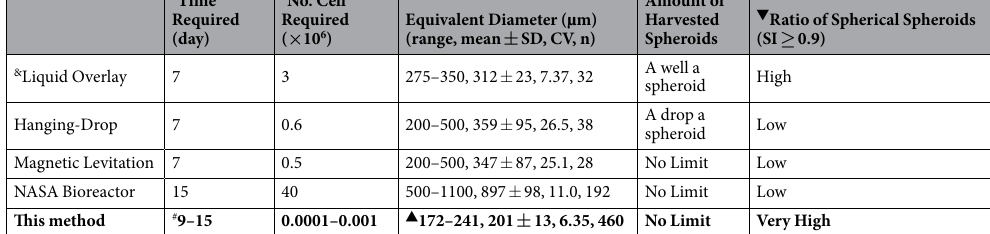
Table 2. Quantitative comparison between our method and other methods. The data of the three methods except Liquid Overlay were from 15 . * Time and number of cells needed to obtain sufficient spheroids to fill a 96- well plate; & Liquid Overlay was performed by using the Corning ® Costar ® Ultra-Low Attachment Multiple Well Plate, and the initial seeding density was 3000/well. A centrifuge was performed after cell seeding to ensure a high level of sphericity. Without centrifuge, spheroids would have low ratio of SI ≥ 0.9. # Depending on which size spheroid was needed, bigger ones needed more time; ▲ The data was obtained from 460 spheroids filtered by 120 and 144 µ m sieves; ▼ Referring to 28 , the SI = Sphericity index was calculated from = and P was the projected area and perimeter of spheroids obtained from ImageJ; the case that > 90% spheroids were spherical (SI ≥ 0.9) was considered ‘very high’, > 50% was considered ‘high’, and < 50% was considered